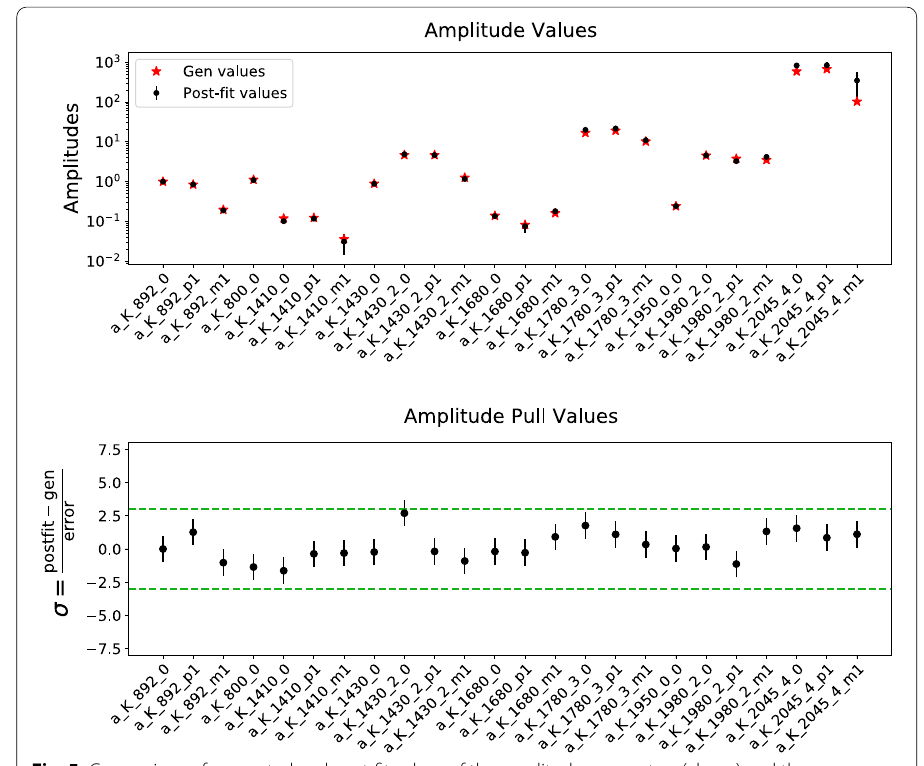
Fig. 5 Comparison of generated and post-fit values of the amplitude parameters (above) and the corresponding pull distribution (below) obtained from a fit to events generated with all the ten K ∗ resonances. The green lines define a ± 3 σ